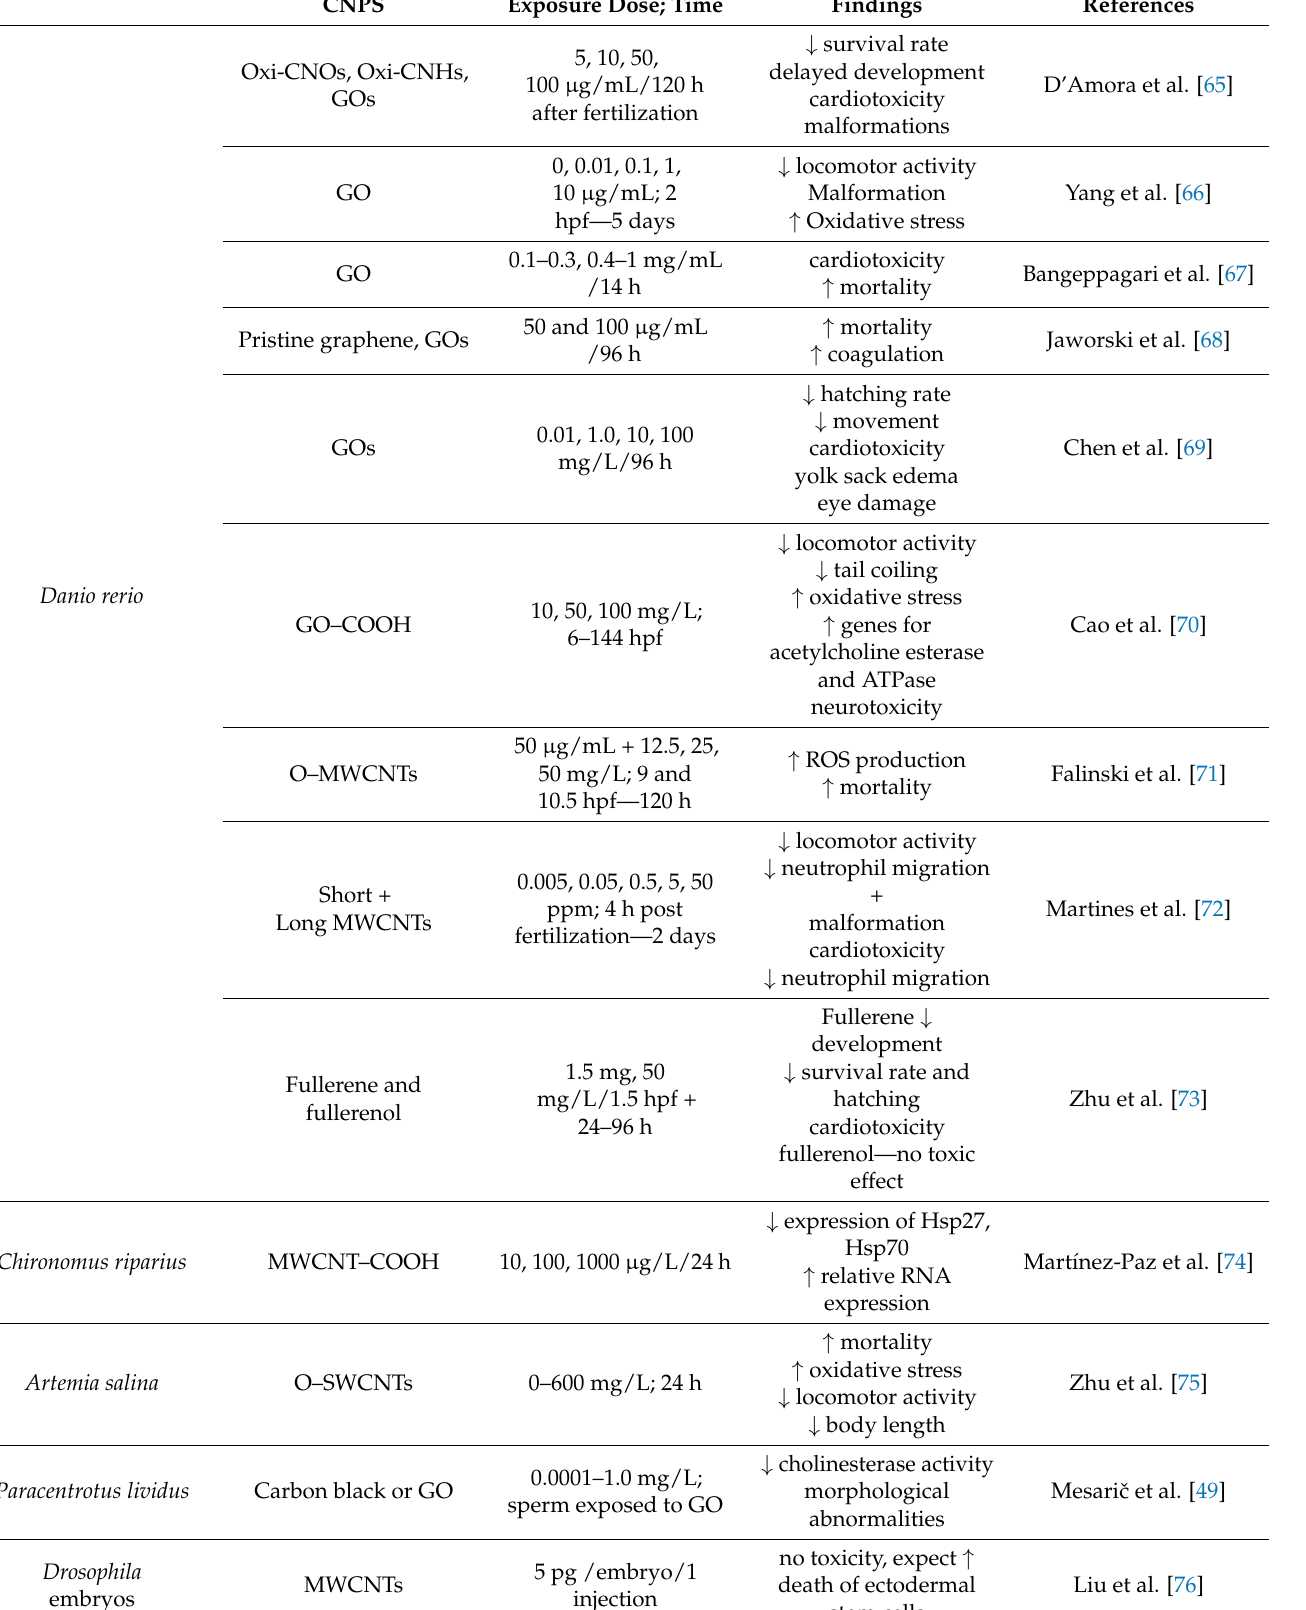
Table 2. Summary: developmental